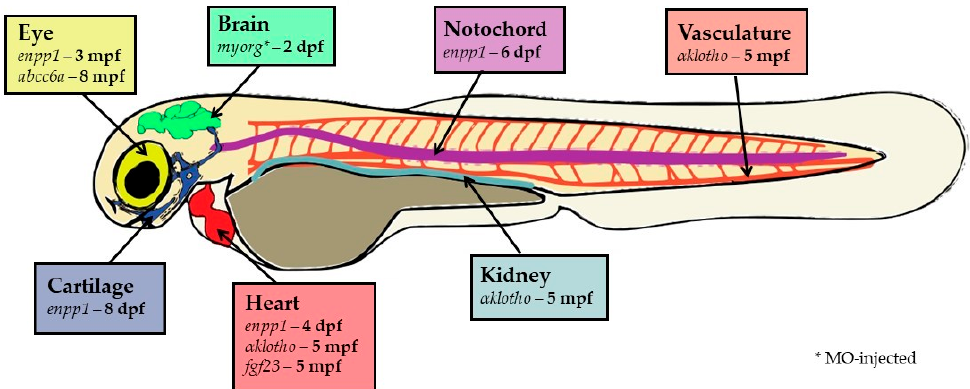
Figure 2. Current models that are available to study ectopic and soft tissue calcification in zebrafish. Information reported here includes target genes, target tissues, and the onset of ectopic calcification